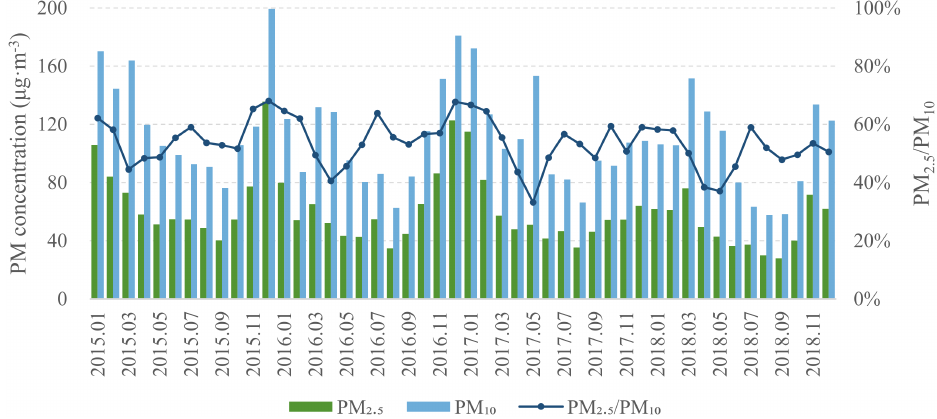
Figure 2. Variation trend of the monthly mean PM concentration in the BTH region from 2015 to